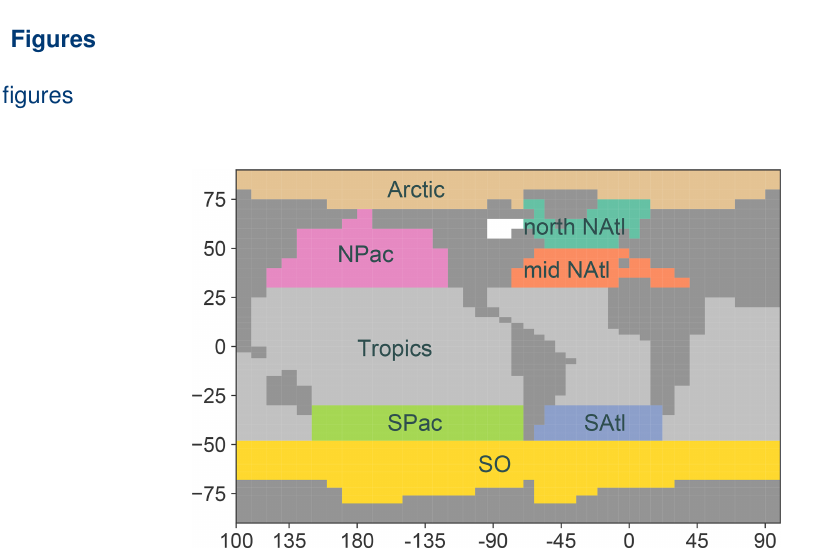
Figure A1. Definition of areas as used for regional SST averages on the Bern3D model grid (Fig. 1b, same colours). Simultaneously, these surface areas define where the eight dye tracers originate (Figs. 8, 9 and A3). The dye tracers are named after the water masses they follow: Arctic, North Pacific Intermediate Water (NPIW, in the area NPac), Tropics, South Pacific Intermediate Water (SPIW, in the area SPac), Southern Ocean (SO), North Atlantic Deep Water (NADW, in the area north NAtl), North Atlantic Intermediate Water (NAIW, in the area mid NAtl) and South Atlantic Intermediate Water (SAIW, in the area SAtl). Together they cover the whole ocean surface except the Hudson Bay. The SO dye tracer contains both AABW and